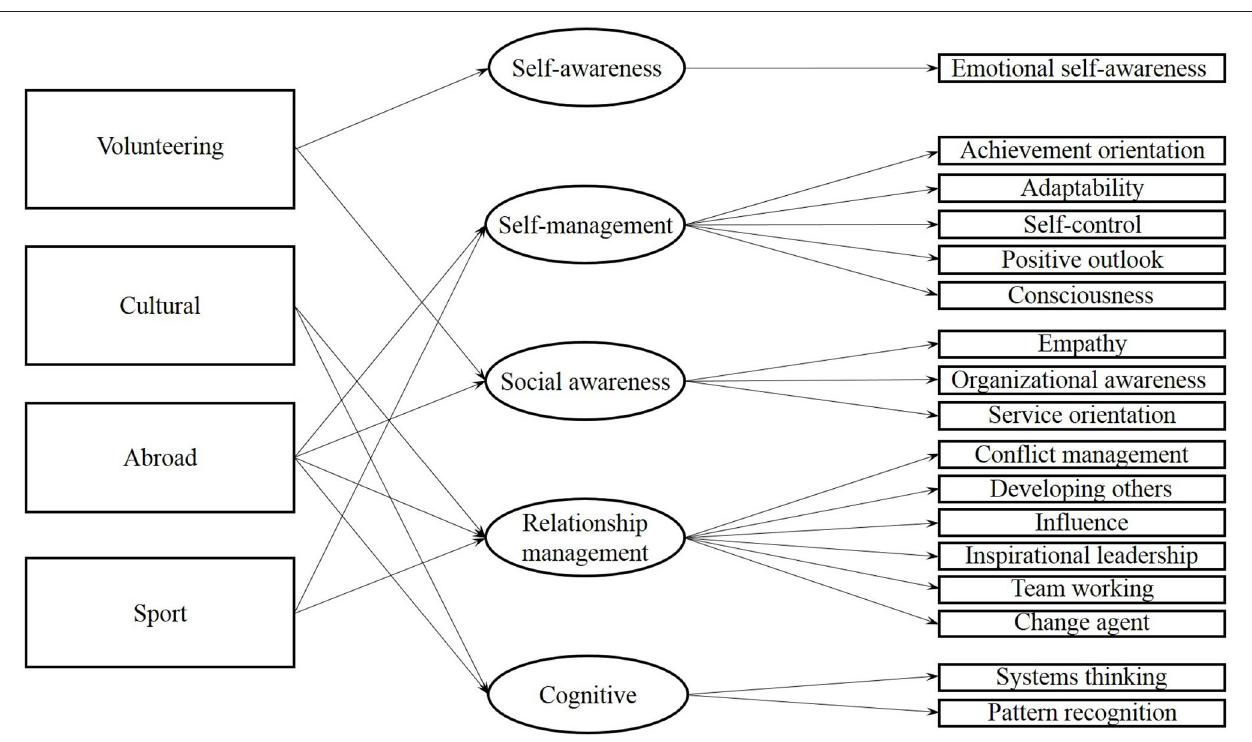
FIGURE 1 | Conceptual model.